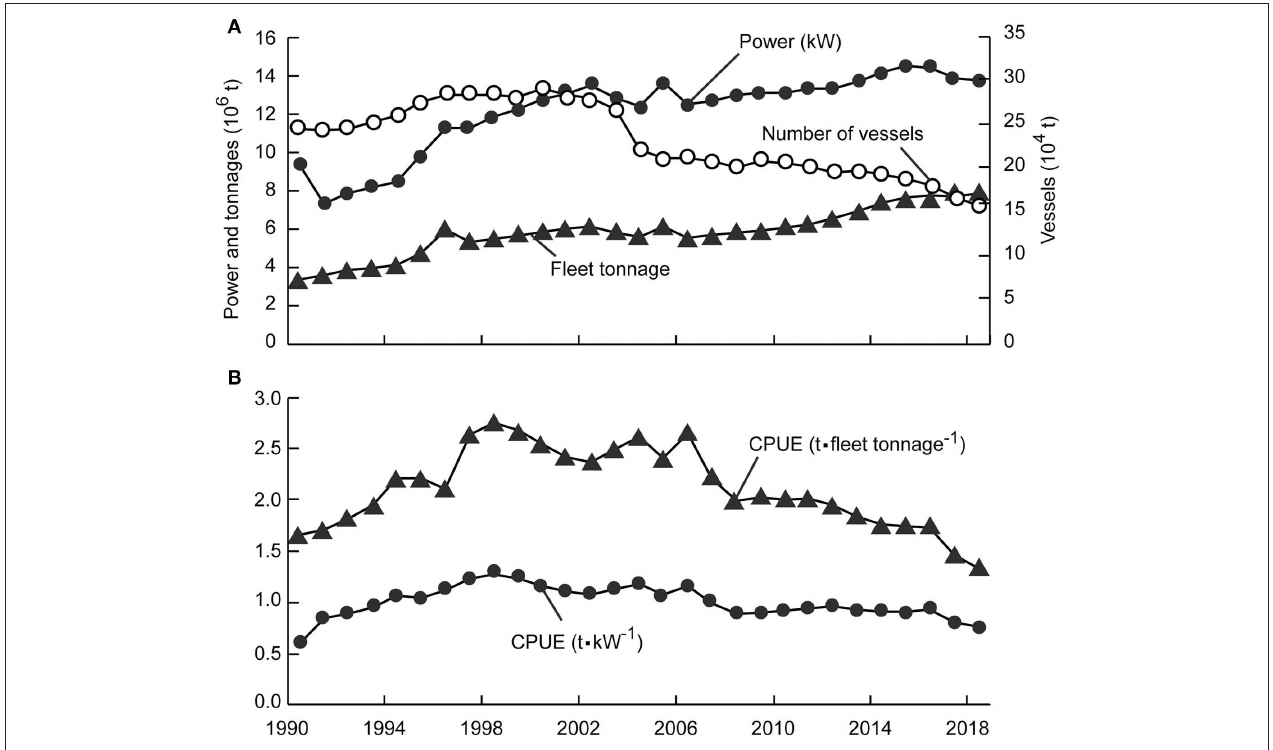
FIGURE 1 | Basic statistics on China’s coastal fisheries (1990–2018). (A) Three proxies of fishing effort; (B) Two measures of catch per unit of effort